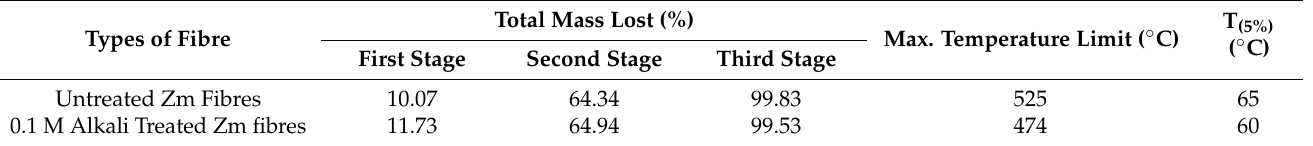
Table 7. Mass loss at T max of untreated and alkali treated Zm fibres.